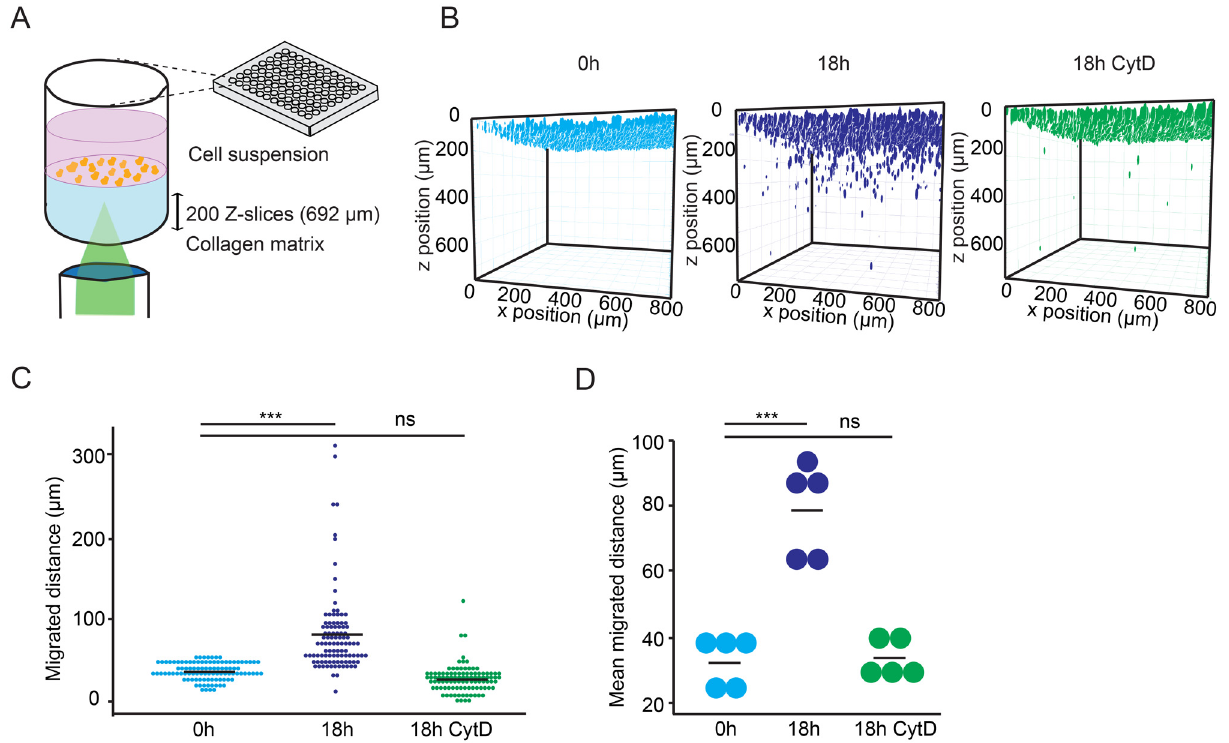
Fig 1. Experimental set-up for DC migration in a 3D collagen matrix. ( A ) Schematic representation of the assay set-up with collagen matrix as indicated under Materials and Methods. DCs were maintained in complete medium (CM) and allowed to sediment on the top of the collagen matrix layer in 96-well plates. After 18 h incubation, the localization of DAPI-labeled DCs in the collagen gel was analyzed by confocal microscopy in 200 z-optical sections as indicated. ( B ) Plots represent, for each condition, the 3D reconstruction assembly of z-stacks as indicated under Materials and Methods. Colored structures indicate the localization of individual DCs (DAPI) at indicated time points ± cytochalasin D (CytD). ( C ) Dot plots represent the distribution of migrated distances for the different conditions. For each condition, 100 single cells were randomly selected and analyzed from one representative donor. Bar indicates mean migrated distance. Asterisks indicate significant differences ( *** : P < 0.001; non-significant (ns): P > 0.05 Kruskal-Wallis test, Dunnett´s test). ( D ) Mean migrated distances by DCs under same conditions as in B and C. Data represent compiled analysis of 500 randomly chosen cells per donor from 5 different donors. Bars indicate mean migrated distances ( *** : P < 0.001, ns: P > 0.05; Two-way ANOVA, Tukey´s HSD test).